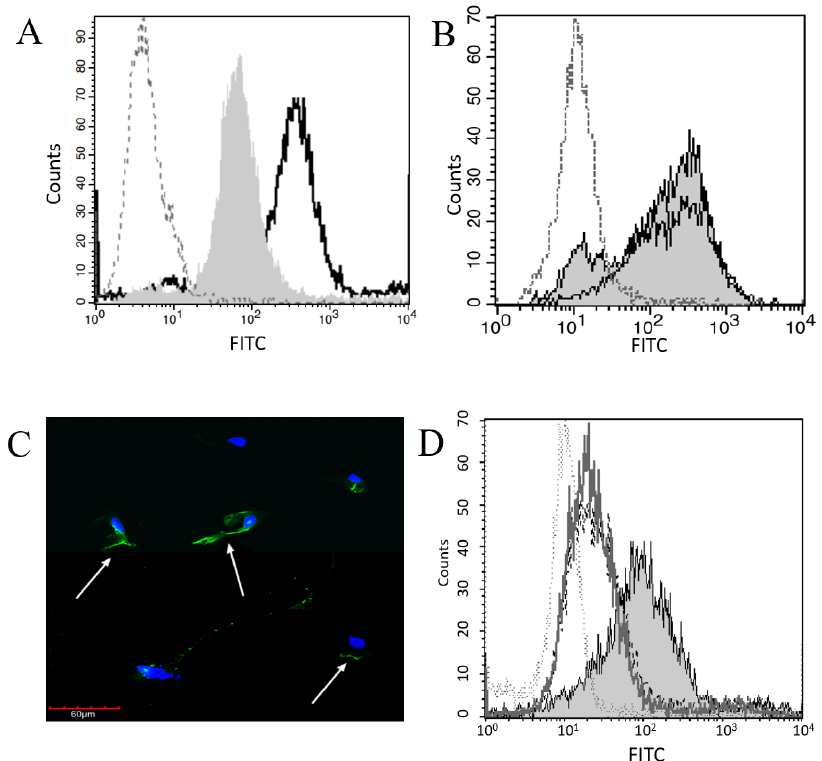
Figure 1. Plg Binds at the Surface of Mesothelial and Macrophage Cells. ( A ) Plg binding to MeT5A cells (grey shaded histogram) was compared to macrophages (——, unfilled histogram) and isotype control ( ···· ). ( B ) Plg binding to MeT5A (grey shaded histogram) and primary peritoneal mesothelial cells (——, unfilled histogram) was compared to isotype control ( ···· ). The Plg binding on all mesothelial cells was significantly higher than isotype control. ( C ) Binding of Plg to MeT5A cells was assessed by confocal fluorescent microscopy. DAPI was used to identify nuclei, and FITC-conjugated anti-Plg antibody used to visualize Plg. Cell surface Plg binding is indicated by white arrows. ( D ) Plg binding was significantly different between MeT5A cells that were serum-starved (grey shaded histogram) grown in 5% FBS (——, unfilled histogram) or 10% FBS (- - -), and isotype control (····) p = 0.05 by one-way ANOVA, n = 4.